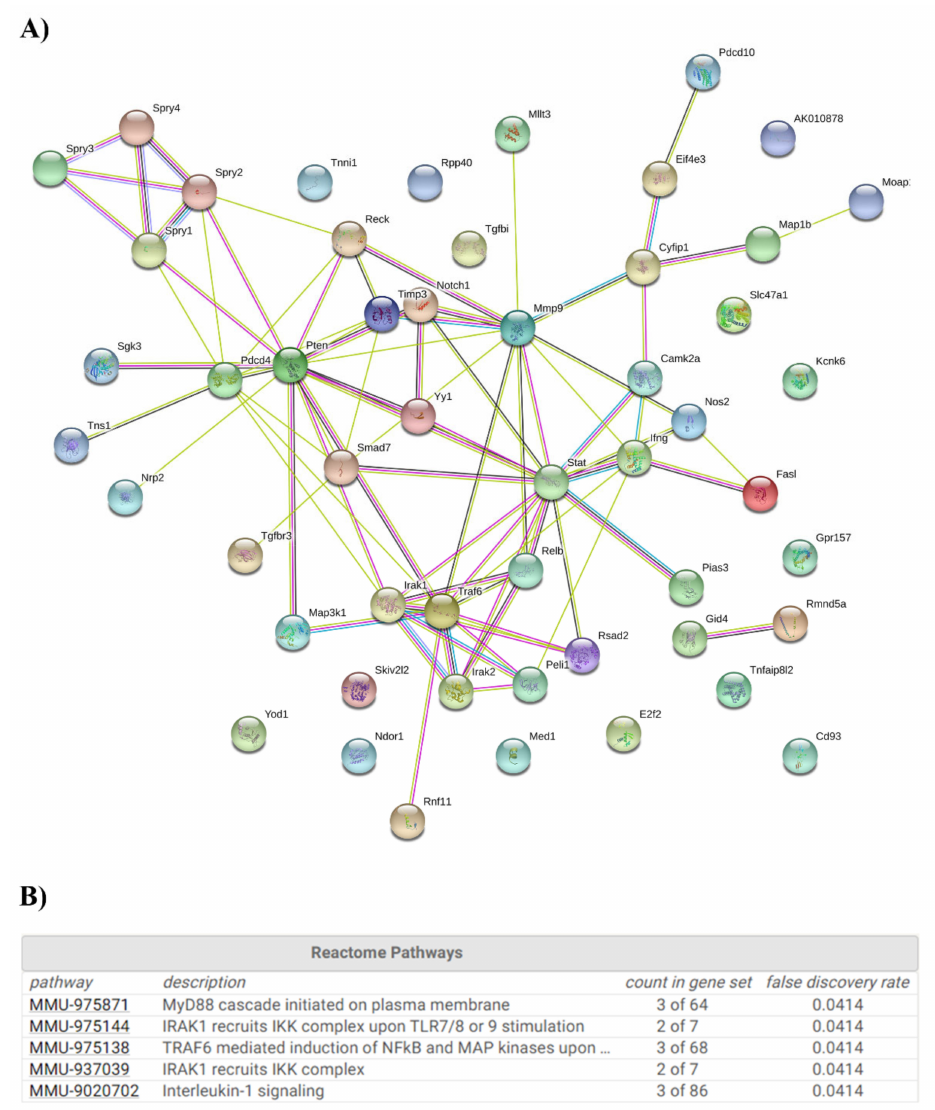
Figure 5. Functional analysis of mir-146a-5p and mir-21-5p. ( A ) Protein–protein interaction for the predicted genes of each miRNA. ( B ) The principal Reactome pathways were modulated by the STRING protein–protein network interaction analysis, performed with the STRING webserver, and p -values are represented as ( − log( p